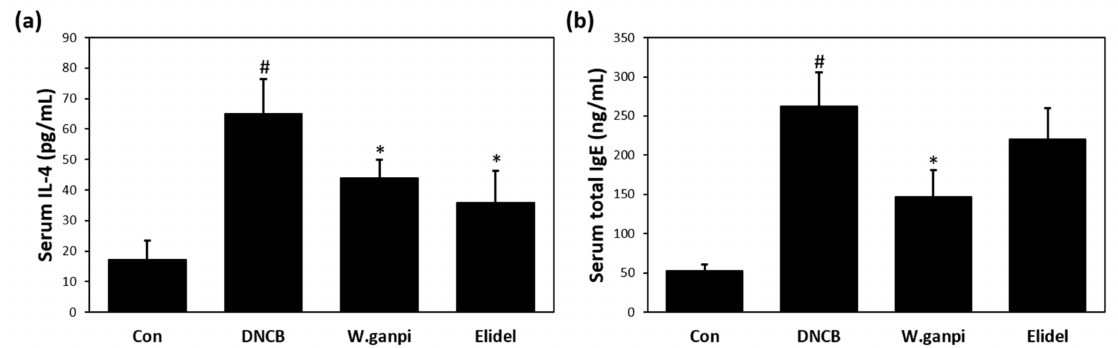
Figure 4. Effects of WGE on the serological change of the IL-4 and IgE concentration in AD-like symptoms induced by DNCB in hairless mice. ( a ) Serum total IgE levels; ( b ) Serum total IL-4 levels. # p < 0.05 vs. the CON group; * p < 0.05 vs. the DNCB group.